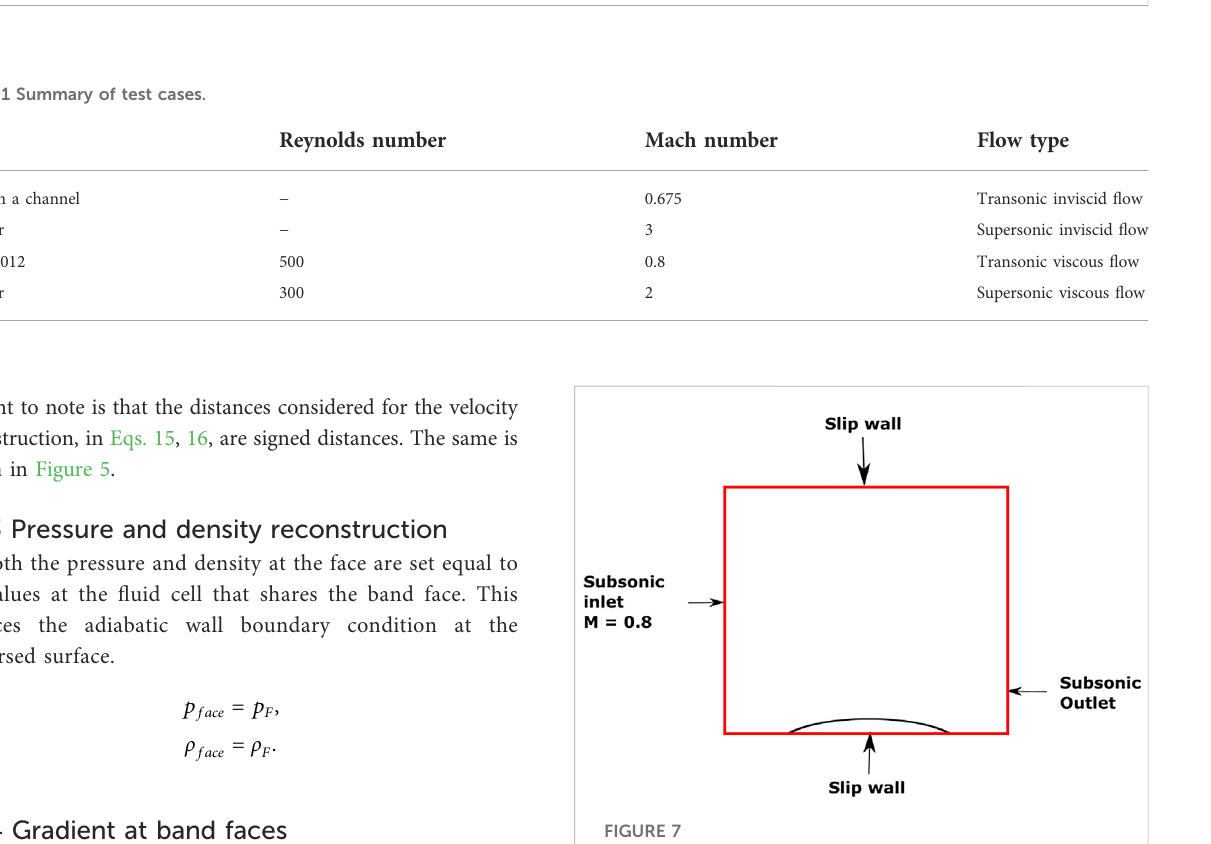
FIGURE 7 Schematic representation of the domain with boundary conditions indicated: transonic fl ow over bump in a